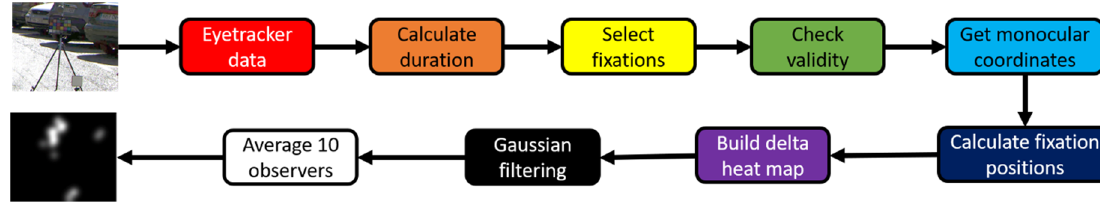
Figure 2. Flowchart followed for building heat maps from eyetracker recorded data.